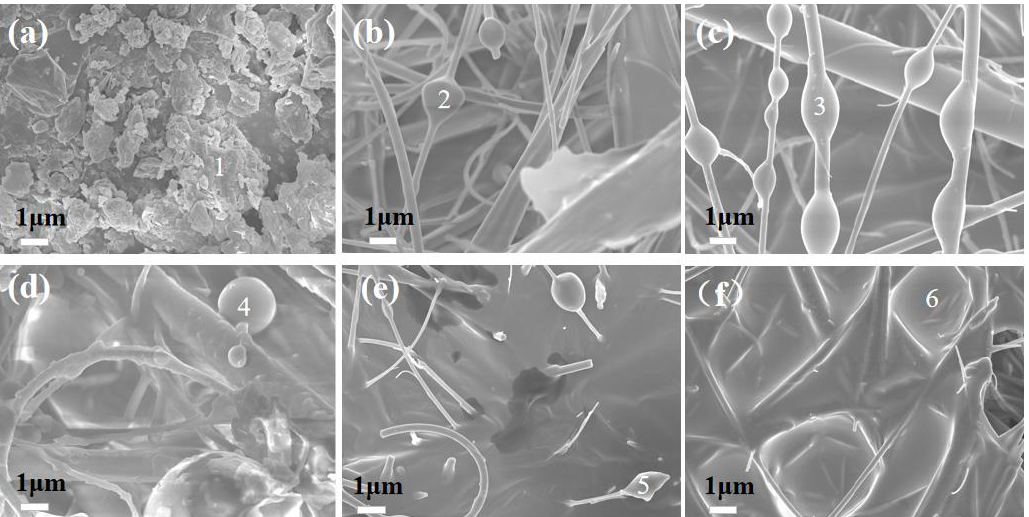
Figure 4. SEM images of PM collected with different temperatures. ( a ) SS, ( b ) PM-300, ( c ) PM-400, ( d ) PM-500, ( e ) PM-600, ( f ) PM-700. SS, sewage sludge. PM-X, PM derived from sewage sludge pyrolysis at X (°C) temperature.